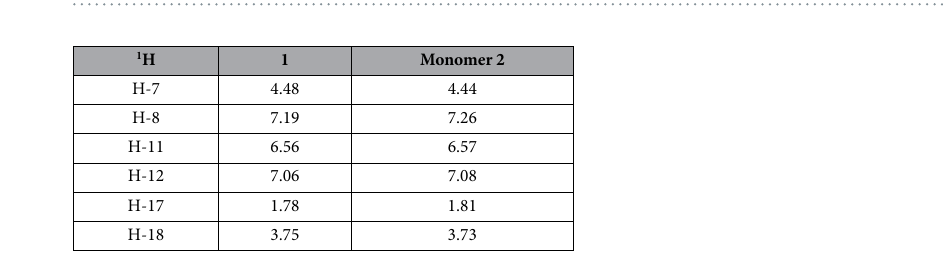
Table 5. Comparison of key DFT calculated NMR chemical shifts between colchicine 1 and Monomer 2